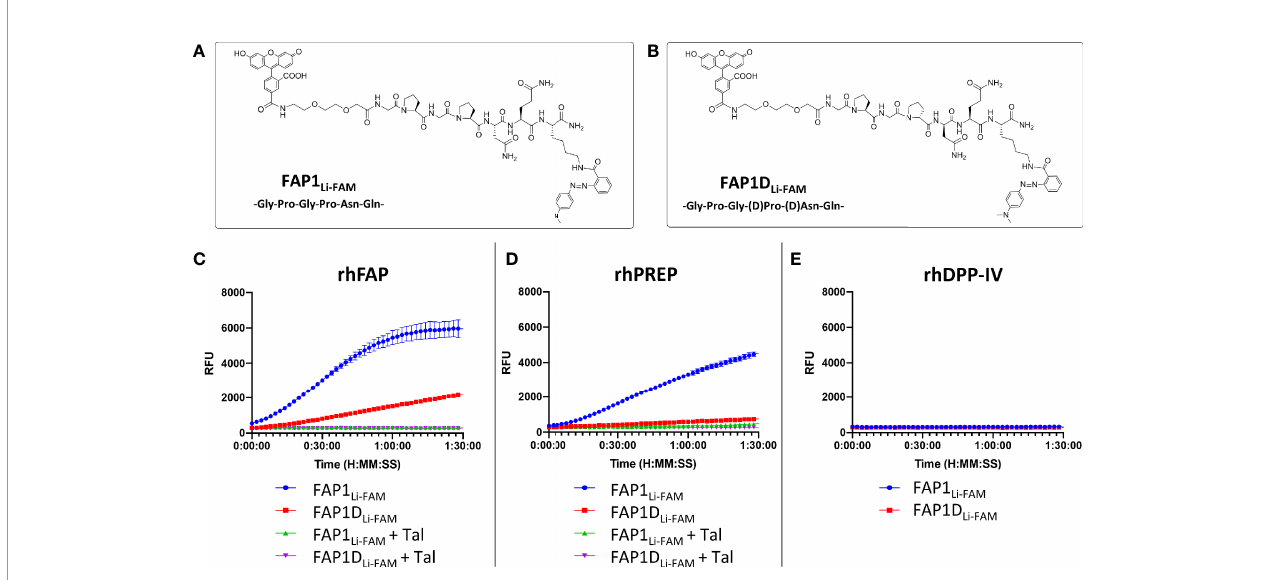
FIGURE 1 | FAP1 probes with recombinant human enzymes rhFAP, rhPREP and rhDPPIV to assess endo and exopeptidase activity. (A) The structure of FAP1 Li-FAM ; (B) The structure of FAP1D Li-FAM ; (C) Each probe (at 5µM) incubated with rhFAP with and without the inhibitor Talabostat (Tal). FAP1 Li-FAM is cleaved rapidly by rhFAP, FAP1D Li-FAM shows lower rate of cleavage and Talabostat inhibits both probes; (D) Probes (5µM) with rhPREP demonstrating cleavage of FAP1 Li-FAM and FAP1D Li-FAM , although FAP1 Li-FAM is cleaved more rapidly. Talabostat inhibits cleavage of both probes by rhPREP; (E) Probes (5µM) with DPP-IV, demonstrating no activity. Representative plots shown, n=3 for each experiment, run in